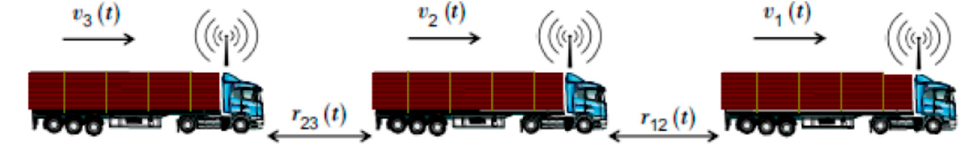
Figure 1. Concept of trucks platooning [1].